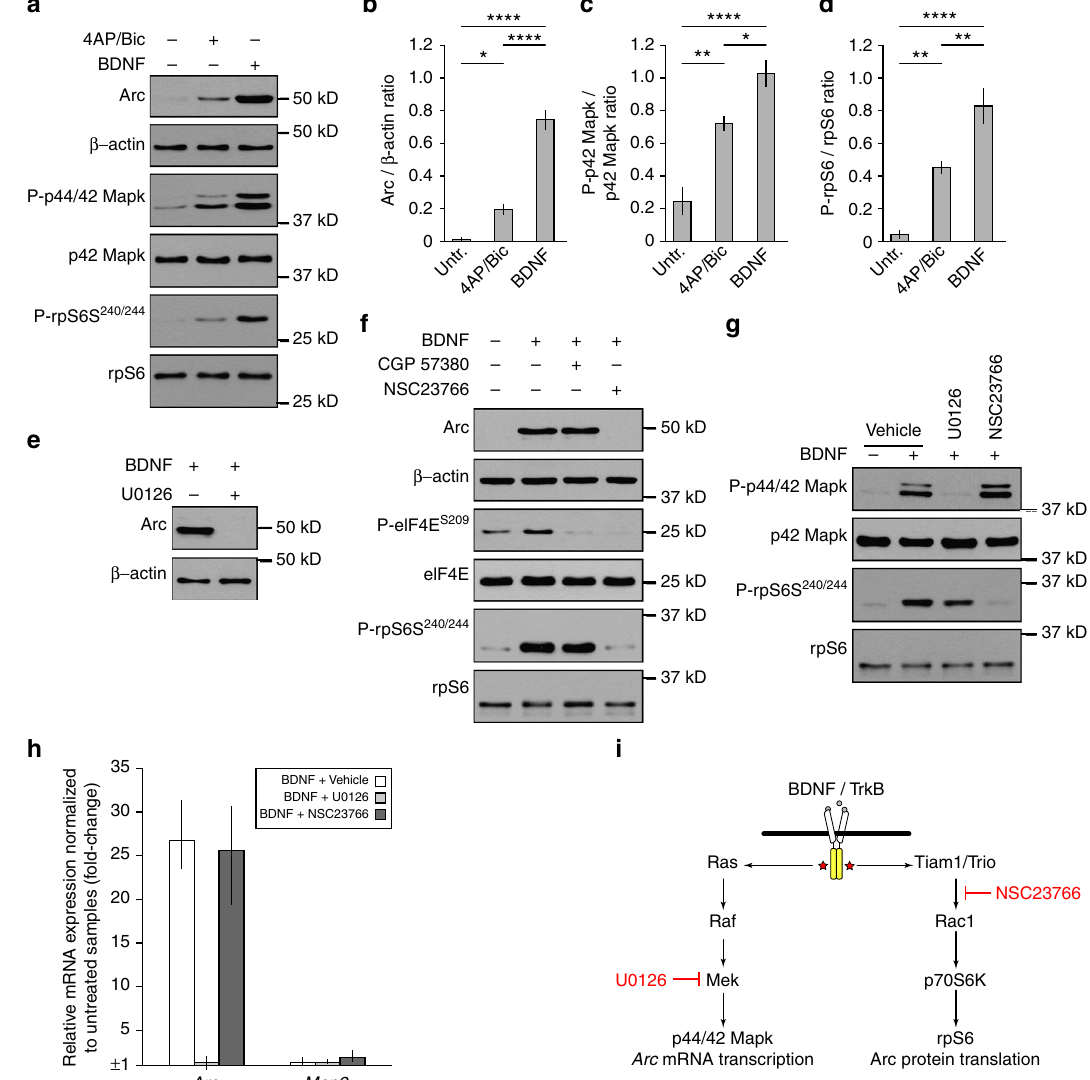
Fig. 1 Pro fi ling of signaling pathways supporting BDNF-induced Arc expression in mouse primary cortical neurons. a Western blots showing levels of Arc, phospho-p44/42 Mapk, and phospho-rpS6 in DIV13 primary cortical neurons that were treated for 6 h with a 4AP (40 µ M) + Bic (50 µ M) cocktail or BDNF (100 ng ml − 1 ). Untreated cells were included as control. b – d Graphs show mean ( n = 4) Arc/ β -actin ( b ), phospho-p42 Mapk/p42 Mapk ( c ), or phospho- rpS6/rpS6 ( d ) ( ± SEM) ratios for cells treated as in a . One-way analysis of variance (ANOVA) revealed a signi fi cant difference between treatment for each antigen (Arc, F 2,9 = 101.52, p < 0.0001; phospho-p42 Mapk, F 2,9 = 31.74, p < 0.0001; phospho-S6, F 2,9 = 34.49, p < 0.0001). Tukey ’ s HSD post hoc test, * p < 0.05; ** p < 0.01; **** p < 0.0001. e Western blot of Arc protein expression in cortical neurons co-treated for 6 h with BDNF plus vehicle (DMSO) or Mek/Mapk pathway inhibitor U0126 (10 µ M). f Similar experiment as in e was conducted with Mnk1 inhibitor CGP 57380 (5 µ M) or Rac1 inhibitor NSC23766 (200 µ M). Experiments in e , f were done in duplicate and lysates were probed for phospho-eIF4E, phospho-rpS6, and/or phospho-p44/42 Mapk ( g ) as control. h Arc mRNA expression in cortical neurons treated for 6 h with BDNF plus vehicle, U0126, or NSC23766. Inhibition of Mek/Mapk pathway by U0126 prevented BDNF-induced Arc expression but not Rac1 inhibition by NSC23766. Map2 expression was assessed as control. Bars represent mean fold-change measured by RT-qPCR (error bars indicate range from three biological replicates). i Schema summarizing the contribution of Mek/Mapk and Rac1/rpS6 signaling to BDNF-induced Arc expression in primary cortical